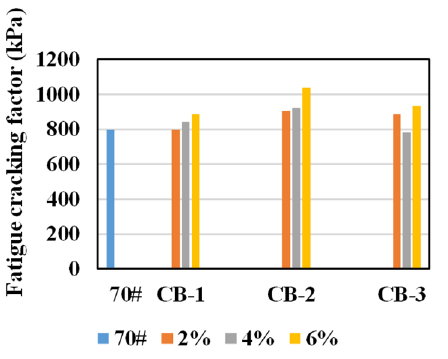
Figure 6. Fatigue cracking factors of unaged asphalt specimens.